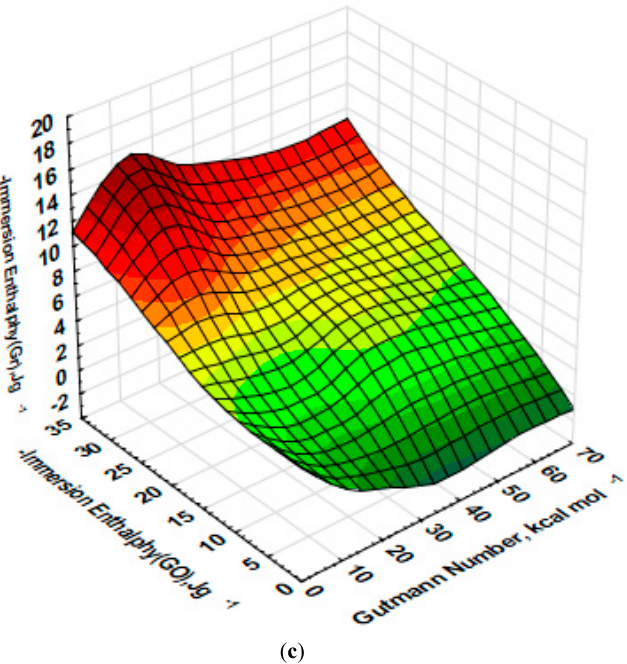
Figure 5. Surface representations: ( a ) immersion enthalpy-Diameter of probe molecule—DN Gutmann for Gr; ( b ) immersion enthalpy—diameter of probe molecule—DN Gutmann for GO; ( c ) immersion enthalpy—DN Gutmann